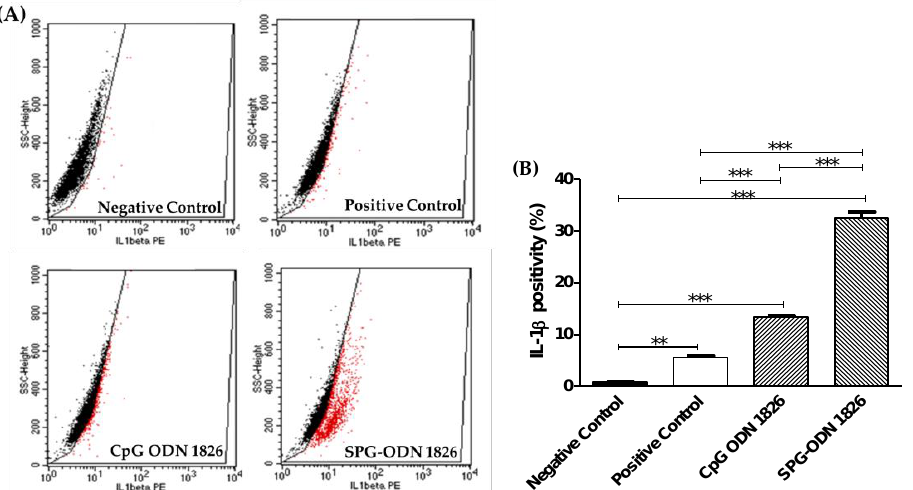
Figure 5. Intracellular staining of IFN- γ within cells. ( A ) PE-mediated positivity of J774A.1 against intracellular levels of IFN- γ as assessed during flow cytometric analysis; Black dots indicate IFN- γ negative cells, while red dots indicate IFN- γ positive cells. ( B ) quantified levels of IFN- γ within J774A.1 cells treated with CpG ODN-1826 and SPG-ODN 1826 nanovehicles with and without LPS stimulation. Data presented are mean ± SEM of three individual experiments, where each was performed individually thrice. Statistical significance between different groups was ascertained using one-way ANOVA and Tukey ’s post hoc test where ** p < 0.01 and *** p < 0.001. Assessment of intracellular IL- 1β levels ( Figure 6) further elucidated the efficacy of the synthesized nanovehicles. The exposure to CpG ODN 1826 resulted in a population increase in IL- 1β -positive cells by slightly more than 2.5-fold (13.67% ± 0.19%; p < 0.001) in comparison to LPS-stimulated J774A.1 cells (5.55% ± 0.34%). Treatment with nanovehicles (34.26% ± 1.23%) further increased the population of IL- 1β -positive cells by ~six-fold in comparison to the positive control cells ( p < 0.001). As in the case of IFN- γ, SPG -ODN 1826 nanovehicles were competent in enhancing the population of IL- 1β -positive M ϕ s more significantly than TLR-9 agonist ( p < 0.001).